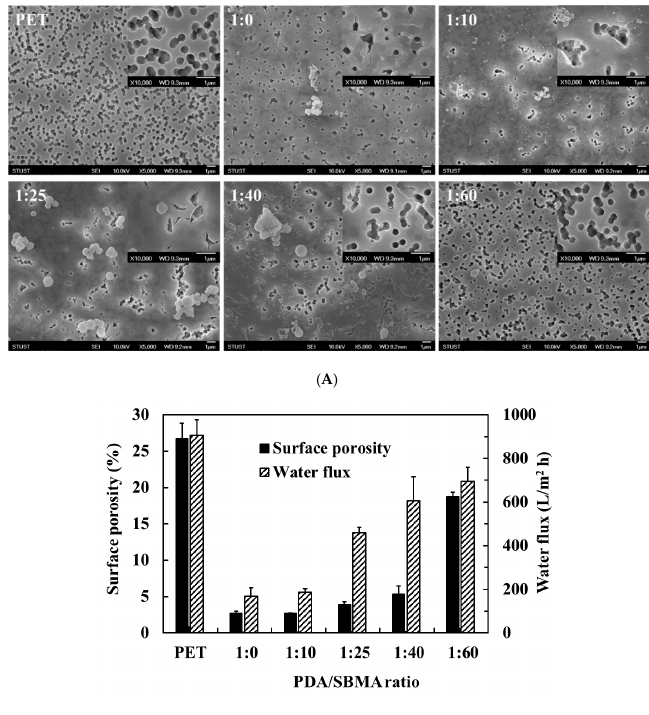
Figure 7. ( A ) SEM images (5000×) and inserts (10,000×) of the various PDA/SBMA coatings on PET membrane. Scale bar = 1 µ m. ( B ) Left: surface porosity of membranes as analyzed from SEM images for various PDA/SBMA modified membranes. Right: performance of various PDA/SBMA modified membranes in terms of water flux.